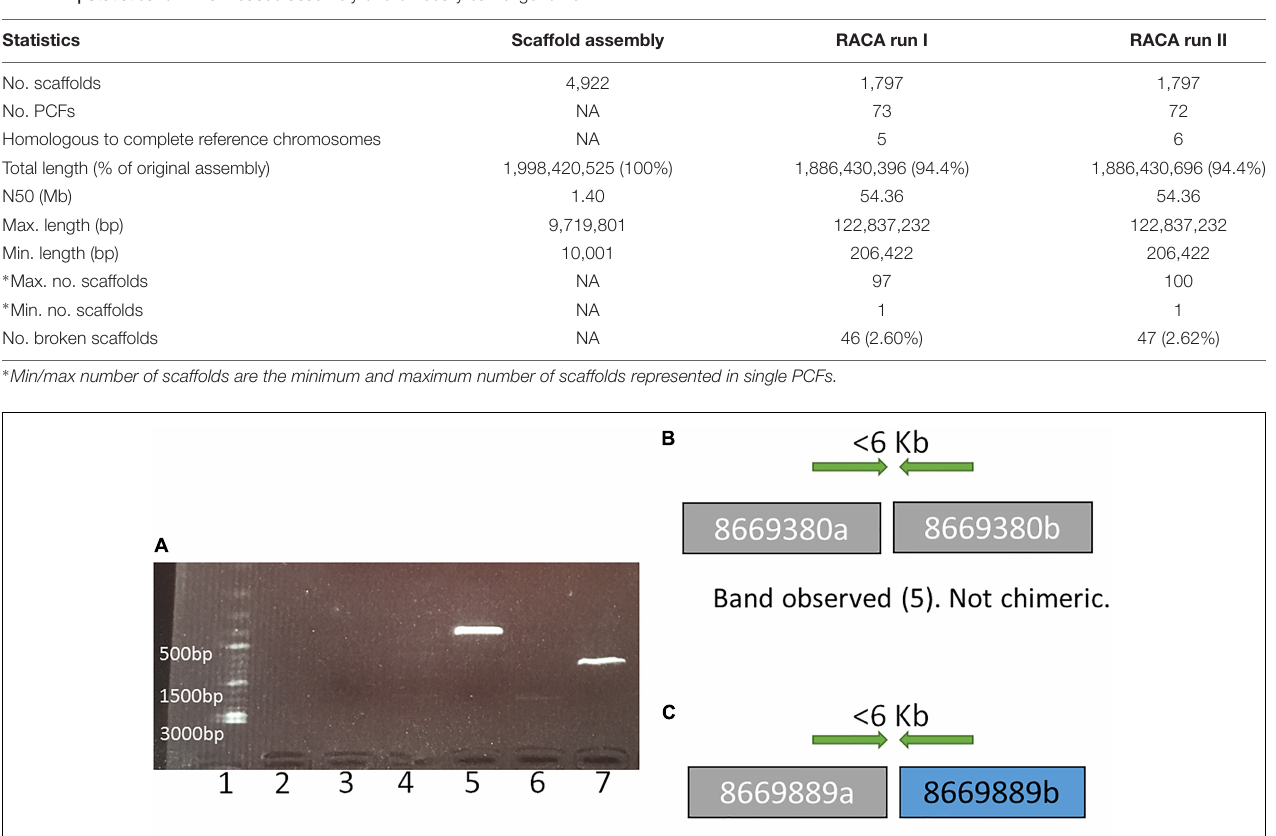
TABLE 1 | Statistics for RACA-based assembly of dromedary camel genome.